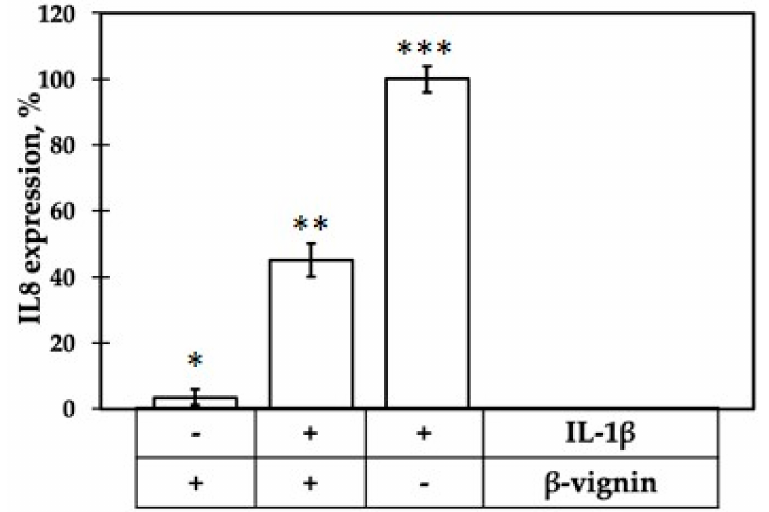
Figure 8. Inflammatory response of Caco-2 cells, assessed as IL-8 expression, elicited by treatment with IL-1 β alone and incubated with β -vignin, in presence (+) or in absence (-) of IL-1 β . Response to IL-1 β alone was set as 100%. Mean value was significantly different: * p ≤ 0.05, ** p ≤ 0.01, *** p ≤ 0.001. See text for experimental